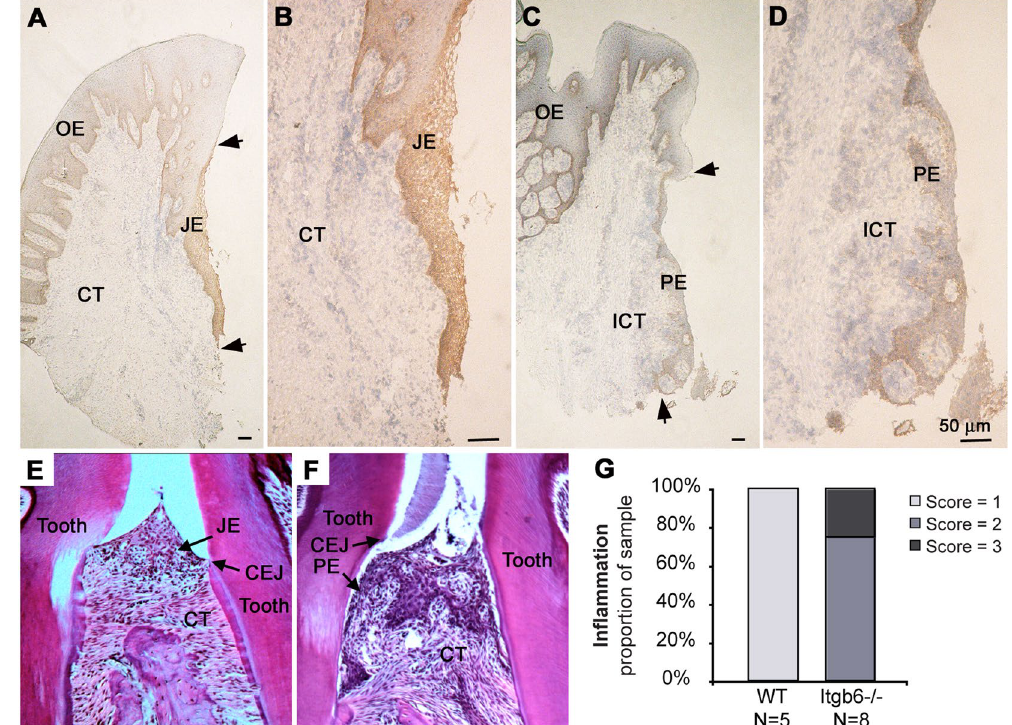
Figure 1. Expression of α v β 6 integrin in human and murine junctional epithelium (JE) and periodontal pocket epithelium (PE). ( A–D ) Expression α v β 6 integrin is expressed in healthy JE ( A and B ) but it becomes strongly downregulated in the PE in periodontal disease specimens ( C and D ). Arrowheads point the most coronal and apical part of the JE ( A ) and PE ( C ), respectively. ( E and F) Hematoxylin-eosin-stained sections of periodontal tissues from WT and Itgb6 − / − mice, respectively. ( G ) Periodontal inflammation scores of the WT and Itgb6 − / − mouse gingiva. OE, Oral epithelium; ICT, Inflamed connective tissue; CEJ, Cemento-enamel